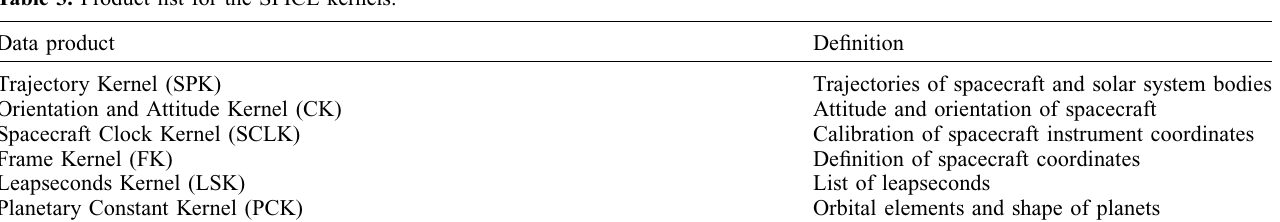
Table 3. Product list for the SPICE kernels.